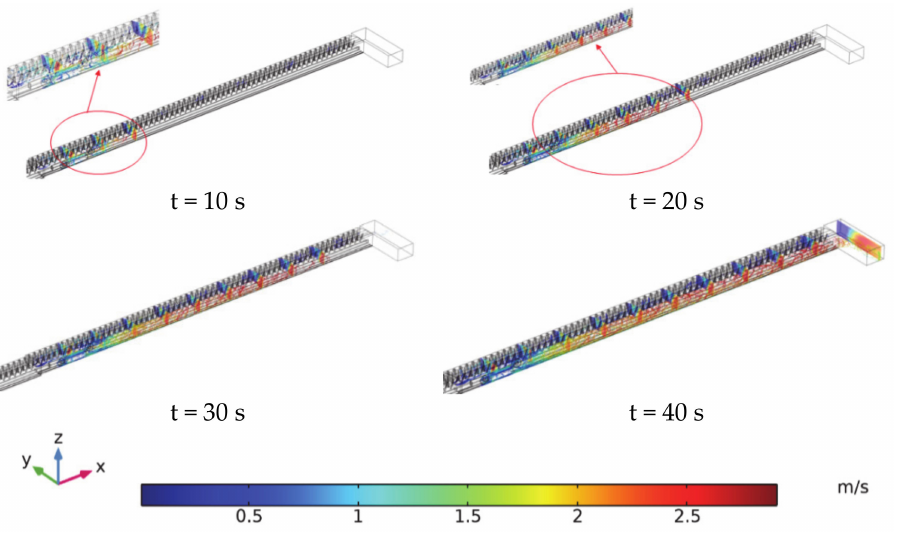
Figure 5. Diffusion results of dust particles at different